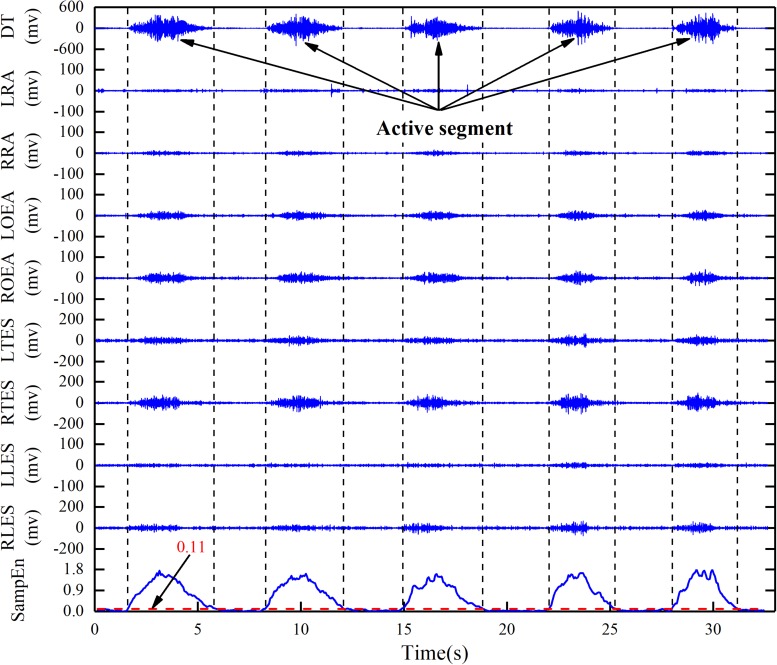
Active segment detection based on adaptive SampEn threshold algorithm in reach-up-to-down motion. DT, descending part of trapezius; LRA, left rectus abdominis; RRA, right rectus abdominis; LOEA, left obliquus externus abdominis; ROEA, right obliquus externus abdominis; LTES, left thoracic erector spinae; RTES, right thoracic erector spinae; LLES, left lumbar erector spinae; RLES, right lumbar erector spinae.